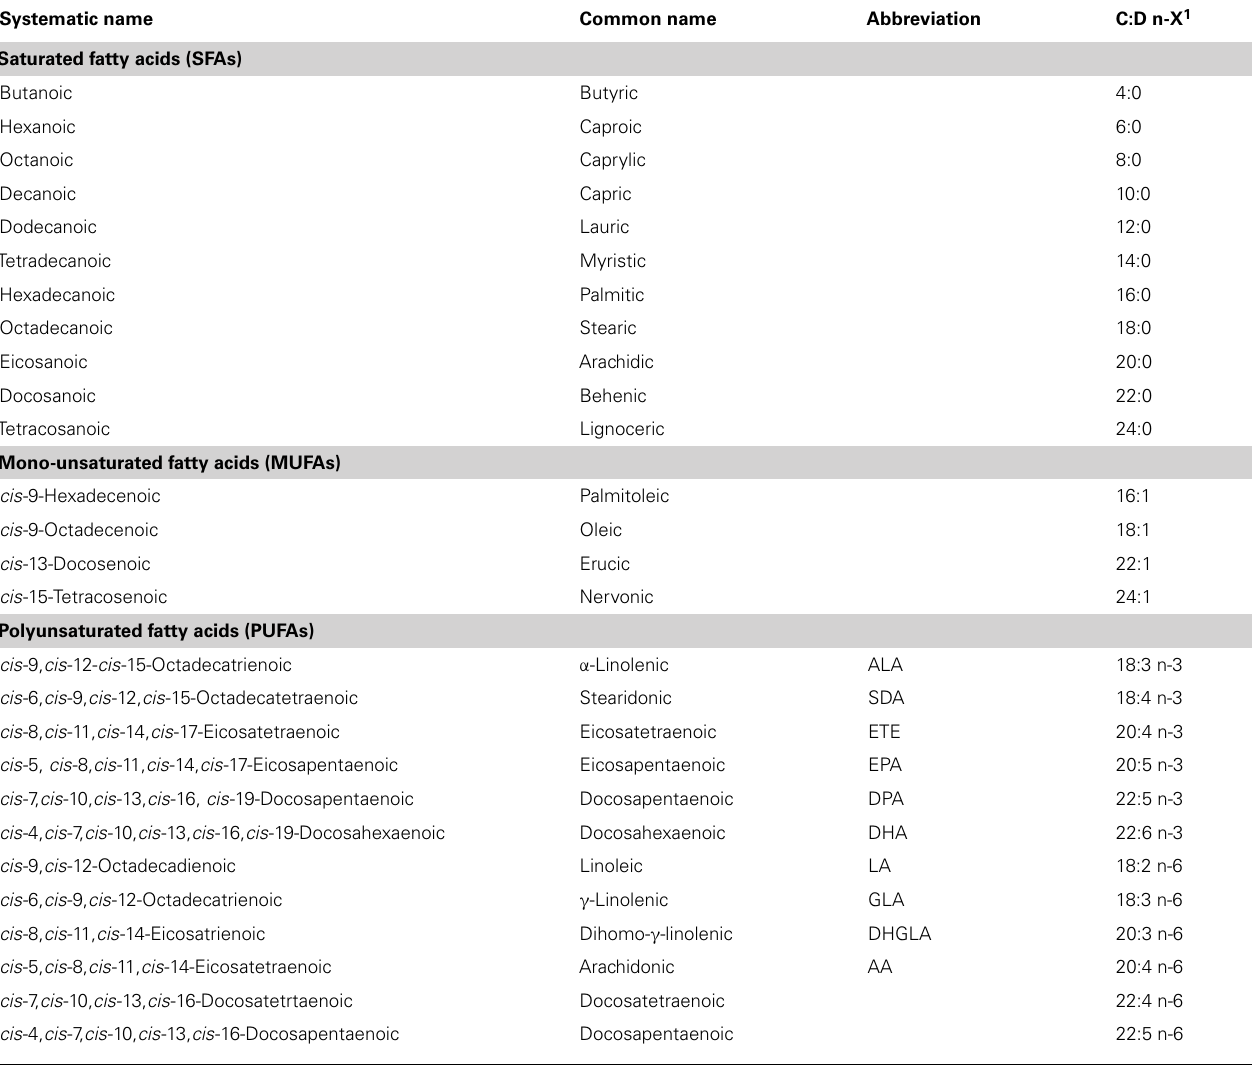
Table 1 | Most typical fatty